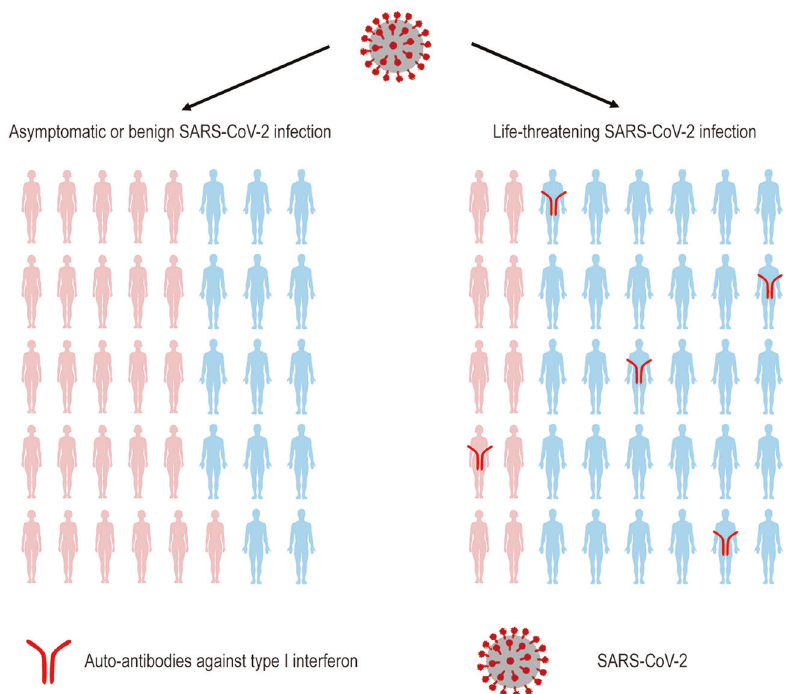
Fig. 1 Patients with life-threatening COVID-19 pneumonia caused by the SARS-CoV-2 virus produce auto-Abs (red) against type 1 IFNs.